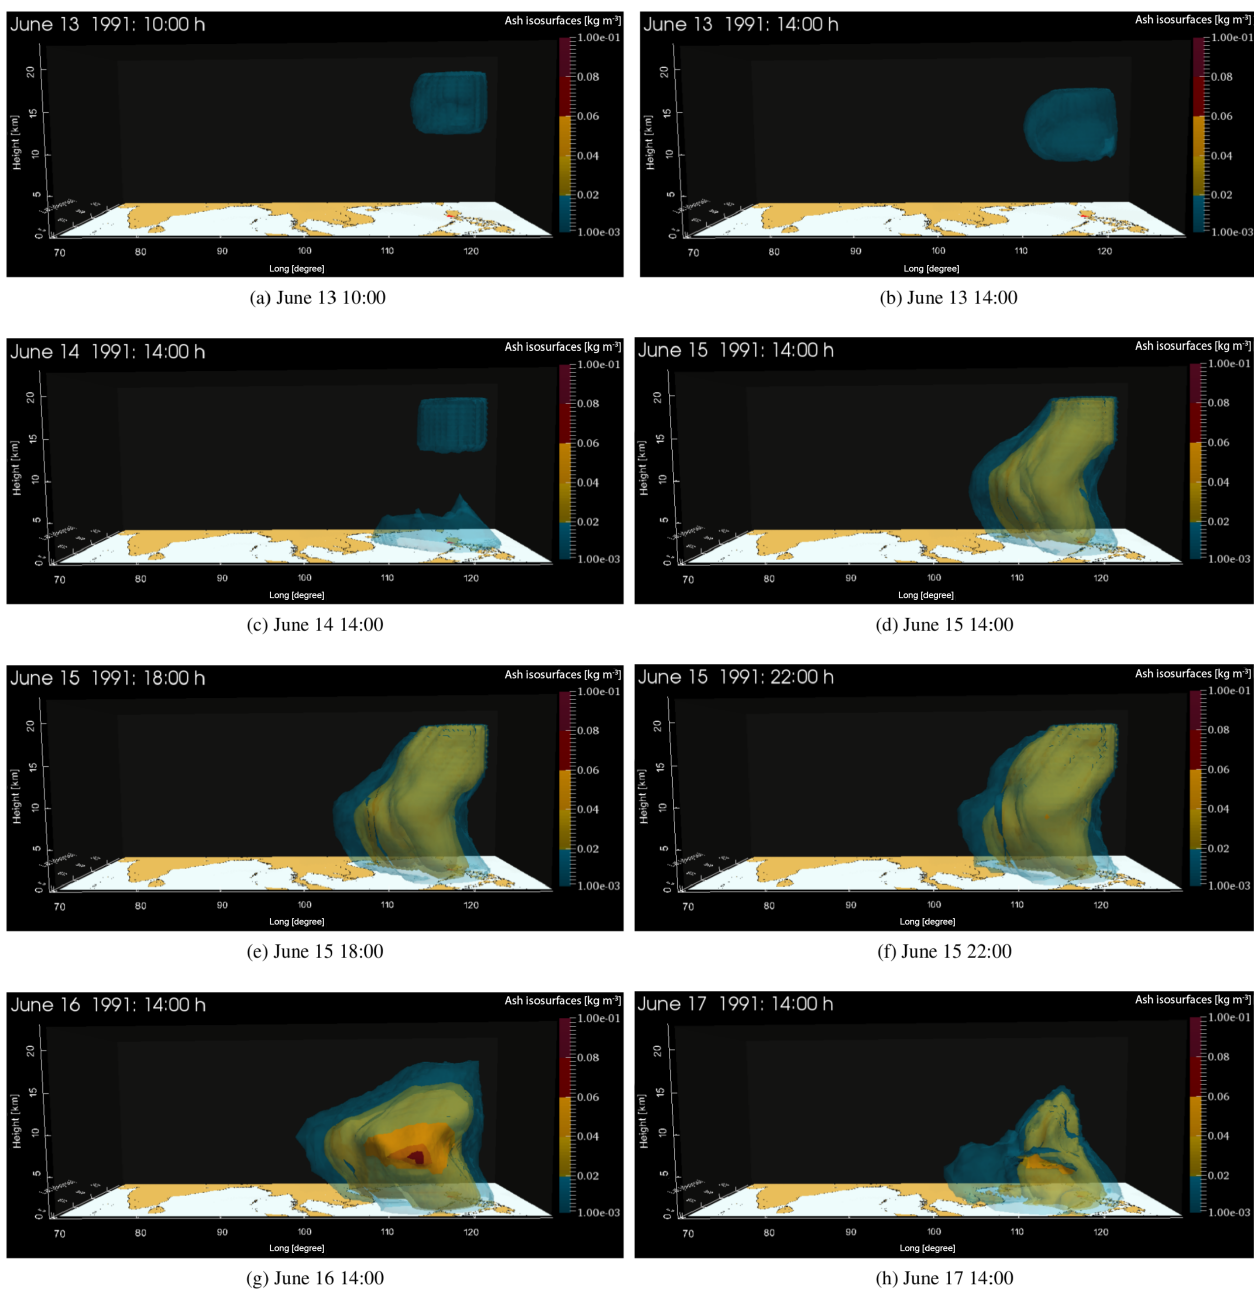
Figure 4. Settling of the ash cloud over time for particles with a grain size of 4.5 φ . The concentration on the surface of the ash cloud is displayed in kg m − 3 . Note that different color bars are used. The minimum displayed ash concentration is 0.001kgm − 3